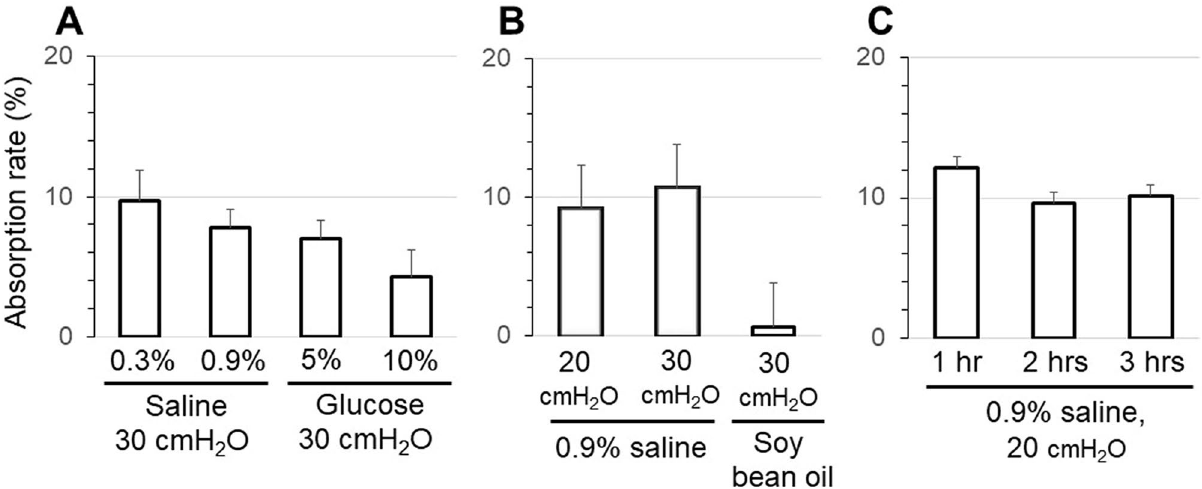
Figure 1. ( A ) The absorption rate of the rat bladder wall was compared under various conditions. Comparison between 0.3 and 0.9% saline and between 5 and 10% glucose under 30 cmH 2 O pressure. ( B ) Comparison when the bladder pressure was maintained at 20 cmH 2 O and 30 cmH 2 O for 2 h and when the bladder was filled with soybean oil. ( C ) Comparison when the bladder pressure was maintained at 20 cmH 2 O for 1, 2, or 3 h. Values are mean ± SEM of measurements in 8